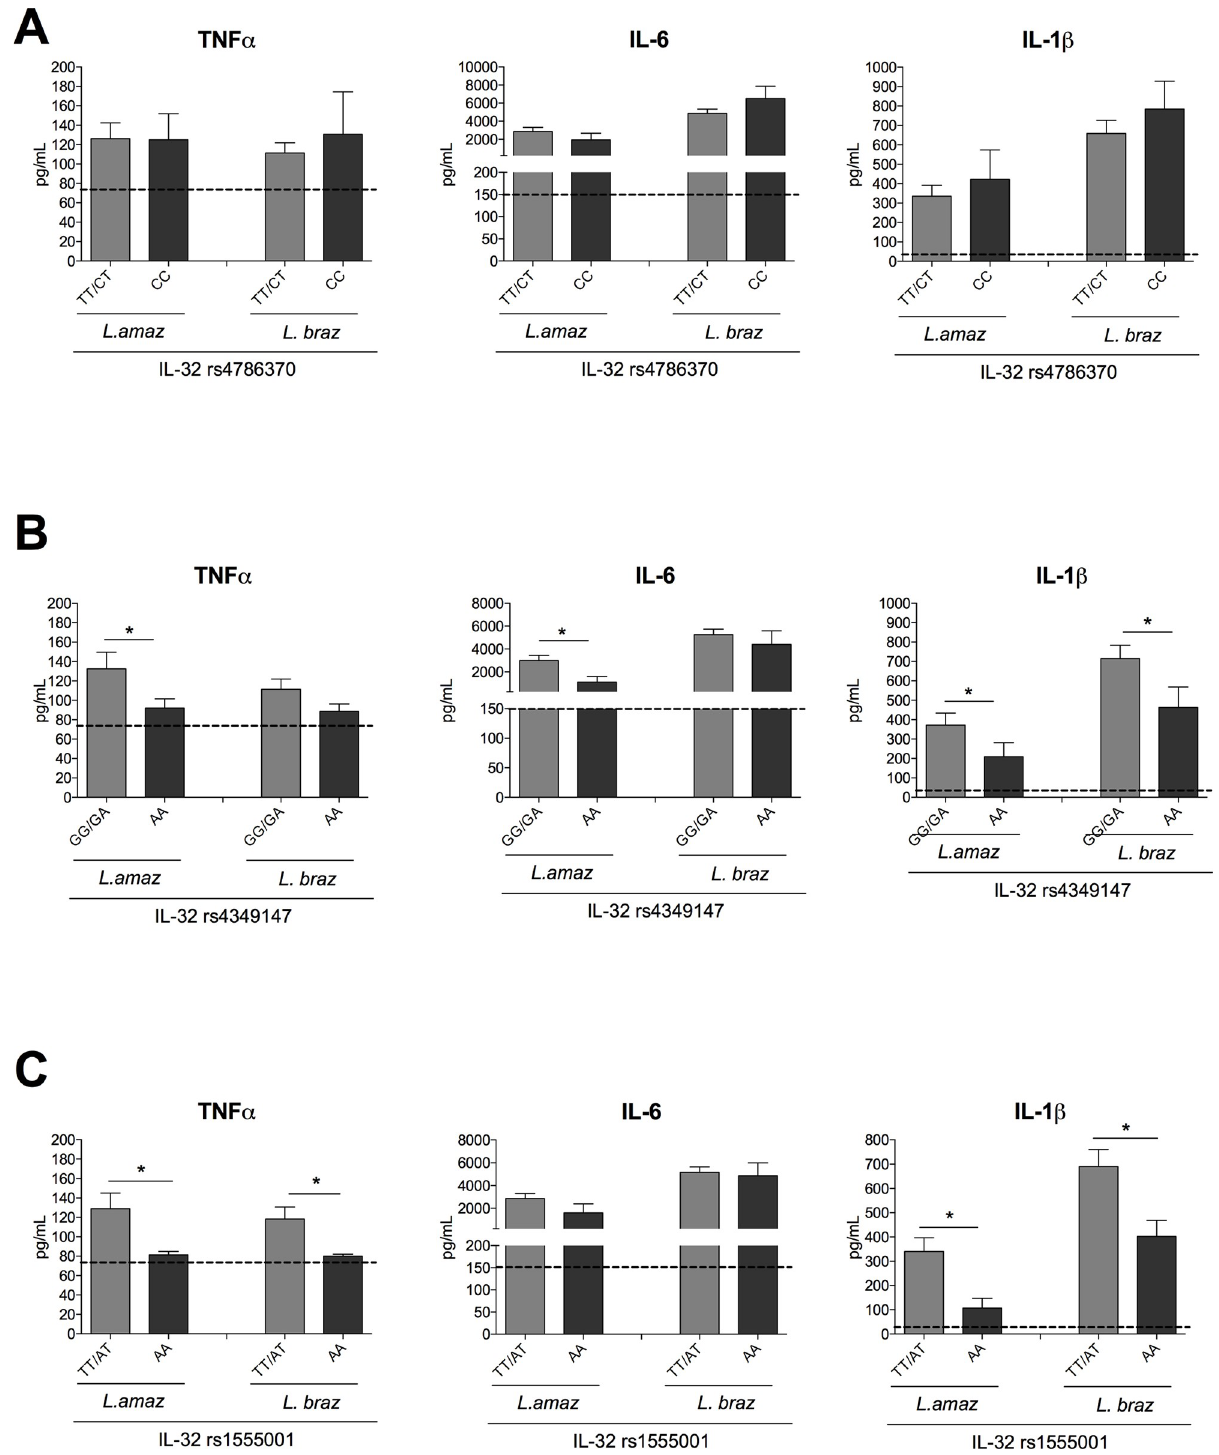
Fig 4. PBMCs from healthy donors from the 200FG cohort were stimulated with lysates (50 μ g/mL) of L . amazonenis and L . braziliensis for 24 hours. Cytokine levels of TNF α , IL-6 and IL-1 β were measured. Cytokine levels were stratified for the different genotypes for (A) IL-32 rs4786370 (TT/ CT n = 139; CC n = 25), (B) rs4349147 (GG/GA n = 140; AA n = 23), (C) rs1555001 (TT/AT n = 146; AA n = 17). Dotted line represents the basal level of cytokine production in the RPMI control. The data shown are the mean ± SEM, � p < 0.05 (TT/CT vs CC; GG/GA vs AA; TT/AT vs AA, respectively, Mann-Whitney U